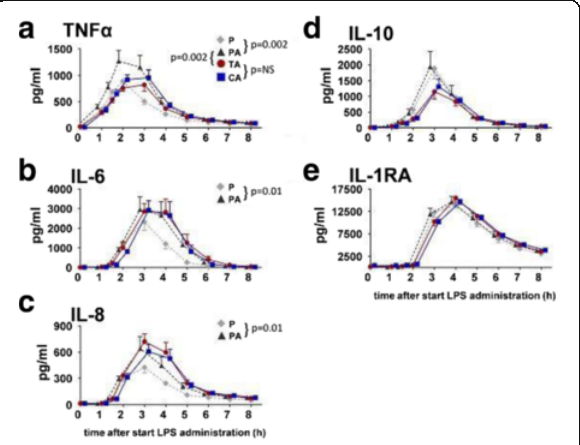
Fig. 141 (abstract A386). Plasma concentrations of (A) tumor necrosis factor (TNF) ɑ , (B) interleukin (IL)-6, (C) IL-8, (D) IL-10 and (E) IL-1 receptor antagonist (IL-1RA) during endotoxin-elicited systemic infalmmation. Data are expressed as means with SEM. Effects of study treatment on the cytokine response were evaluated by com- paring 2 groups with a 2-ways ANOVA. Significant differences be- tween groups are displayed in the figure with a p-value. P: placebo, PA: placebo and acetylsalicylic acid, TA: ticagrelor and acetylsalicylic acid, CA: clopidogrel and acetylsalicylic